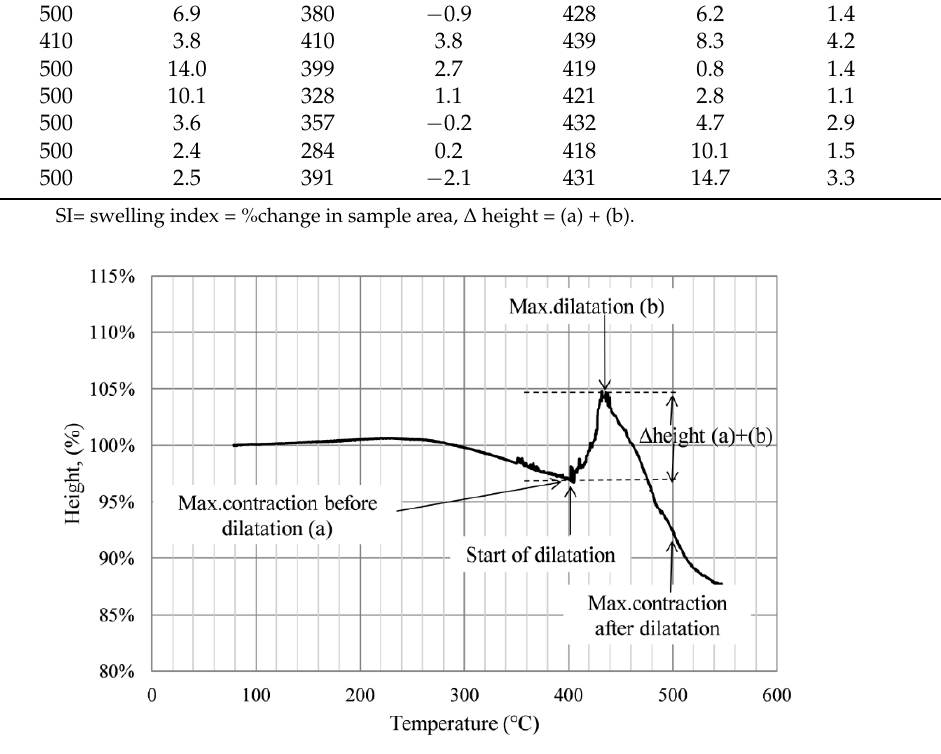
Figure 2. Illustration of the thermoplastic parameters deduced from optical dilatometer tests pre- sented in Table 3.